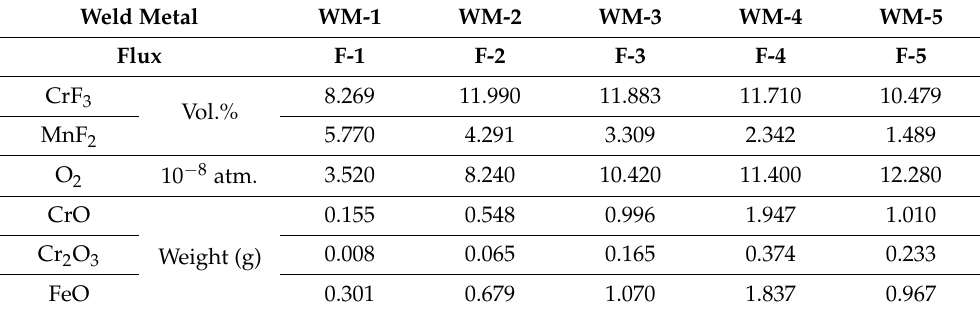
Table A4. Parts of the gas-slag-metal equilibrium calculation outputs under 2273 K for WM of 100 g. Weld